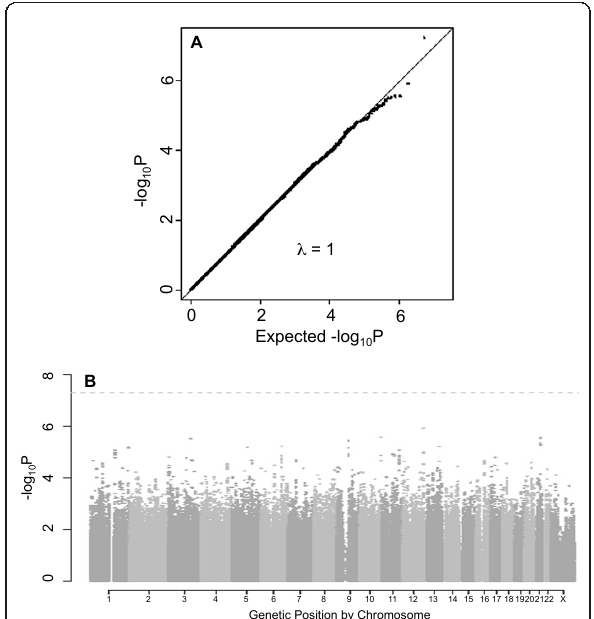
Figure 1 Renal sinus fat genome-wide association analysis results in the overall sample . (a) Quantile-quantile plot for the genome-wide association analysis of renal sinus fat, adjusted for age, sex, and BMI. (b) Manhattan plot of results from the genome- wide association analysis of renal sinus fat, adjusted for age, sex, and BMI. The dotted line represents a -log p-value threshold of 5 × 10 -8